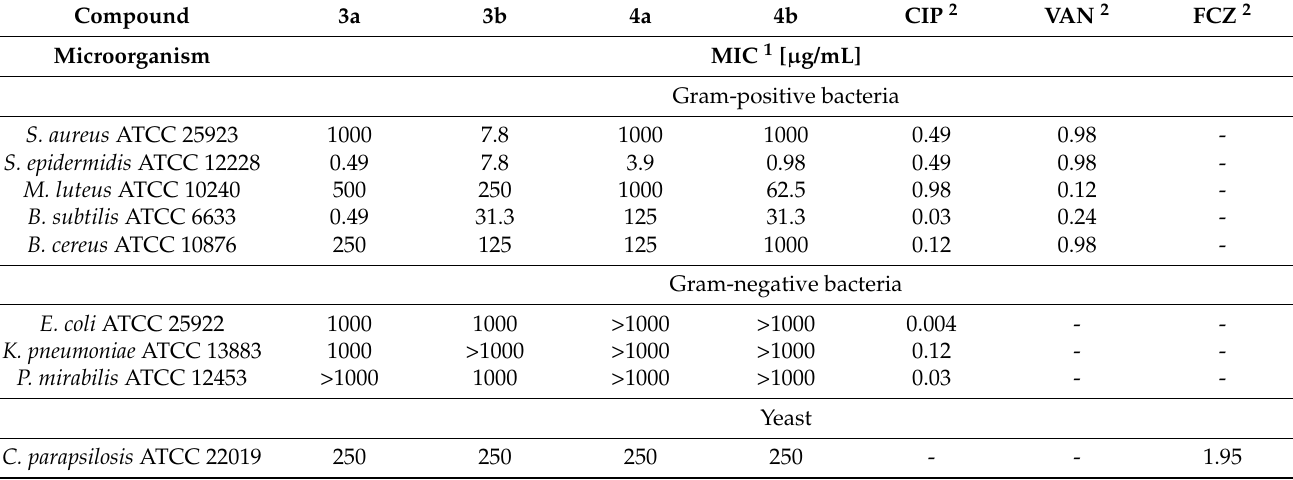
Table 1. In vitro antimicrobial activity of compounds 1,2